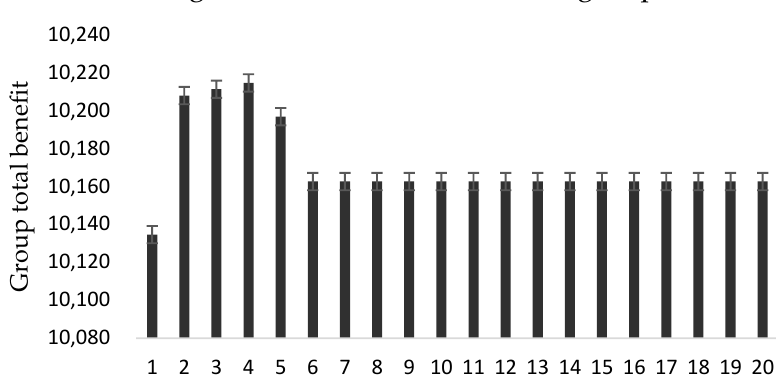
Figure 7. Update of total group benefits.